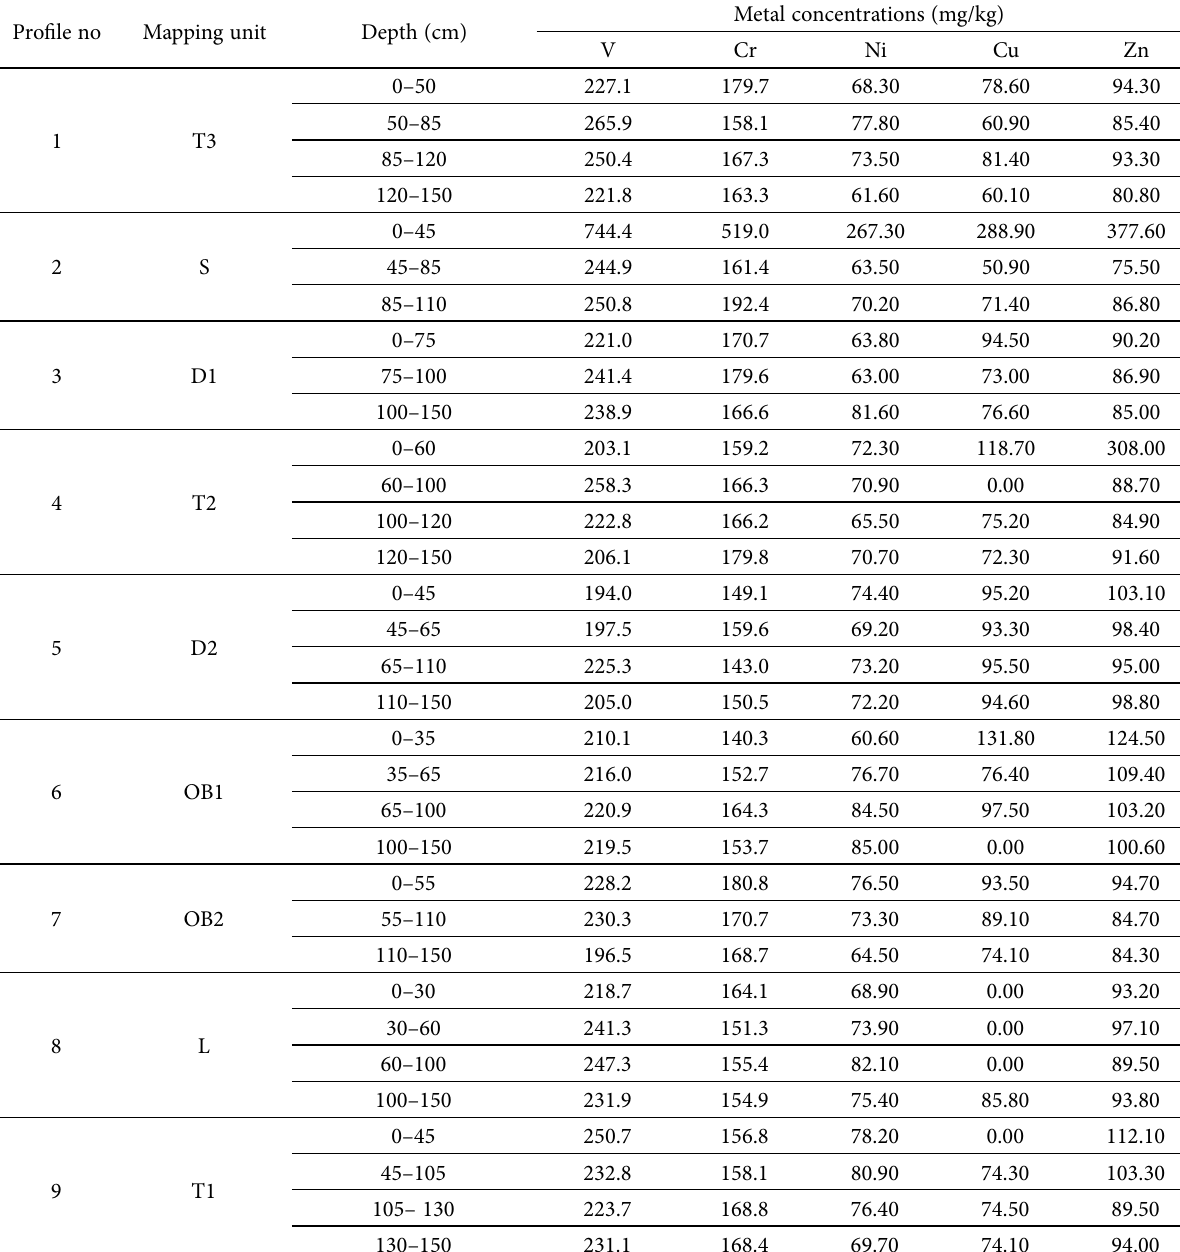
Table 4. XRF analysis of soils collected from the study area Profile